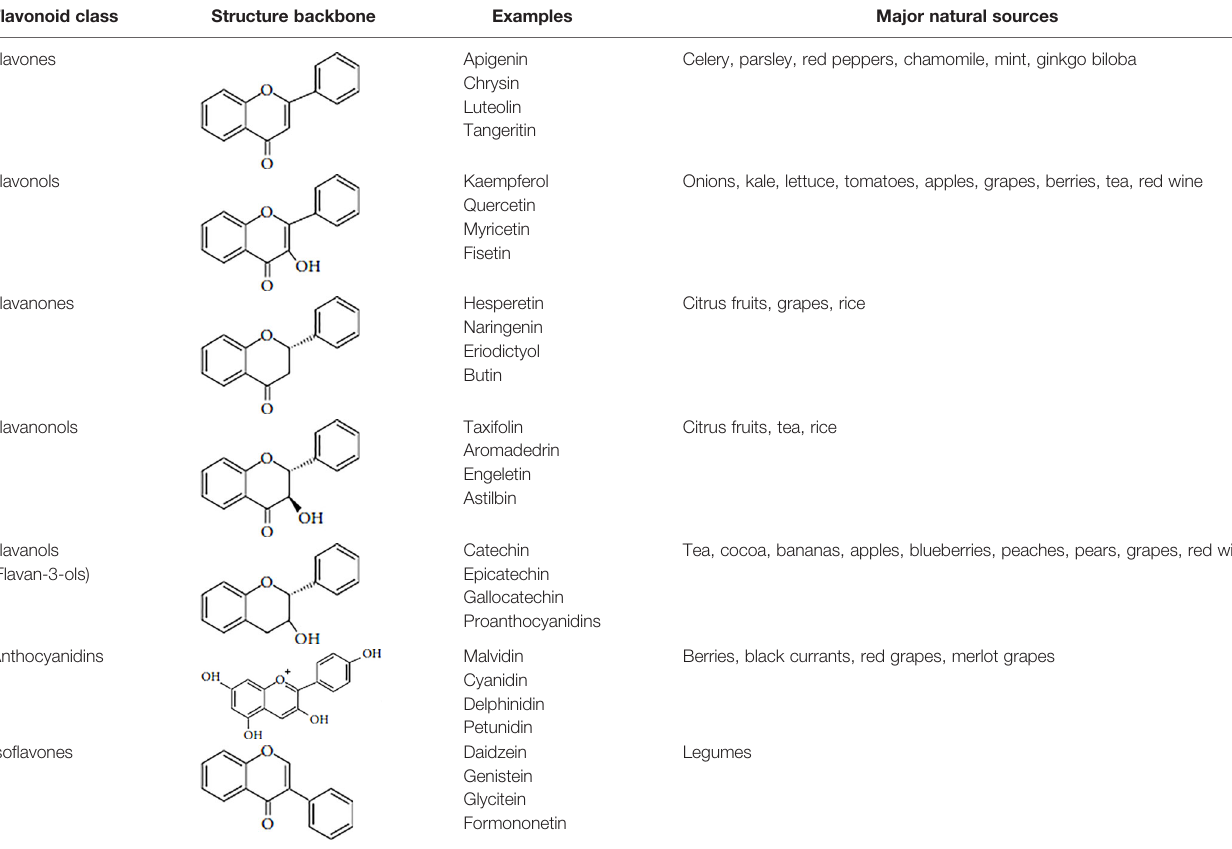
TABLE 1 | Flavonoid classes and their major natural